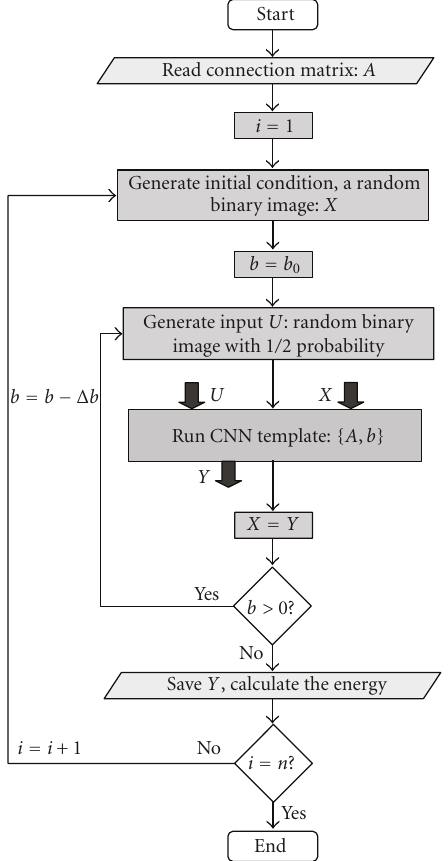
Figure 2: Flowchart of the optimization algorithm using n number of cooling